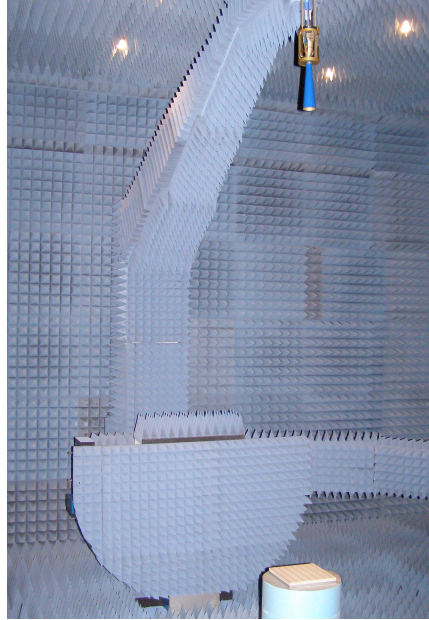
Figure 3. Metal-backed free-space